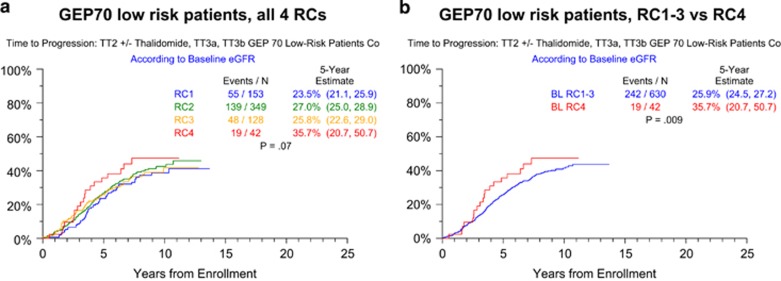
Time to progression in GEP70-defined low-risk myeloma according to RC. (a) By individual RC quartiles; (b) RC4 versus RC1-3.